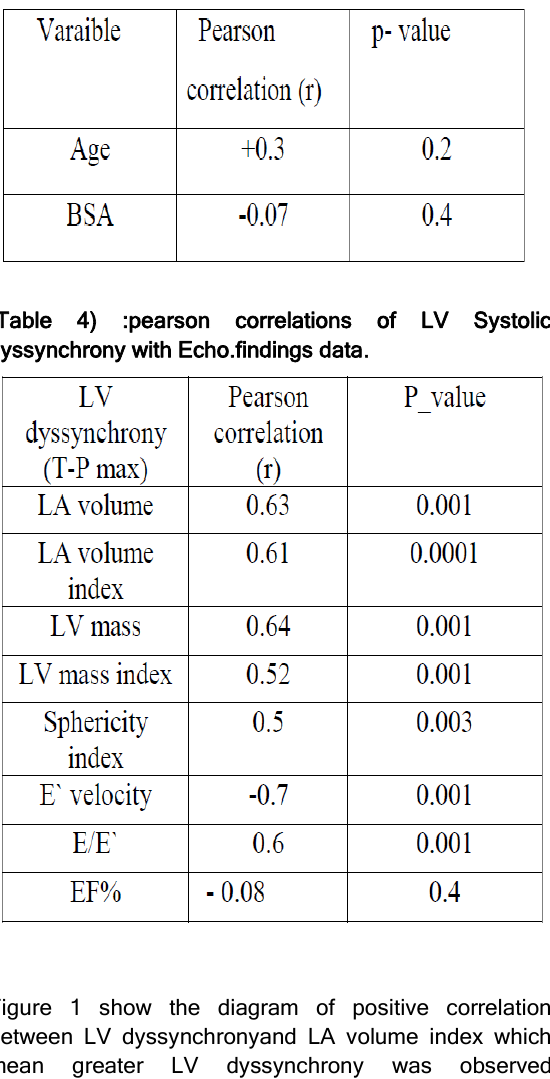
Figure 2 show the diagram of significant positive correlation between LVdyssynchrony and LV mass index ( r= 0.52, p = 0.001). Figure 3 show the diagram of positive correlation between LV dyssynchronyand LV sphericity index (r = 0.5, p = 0.003).